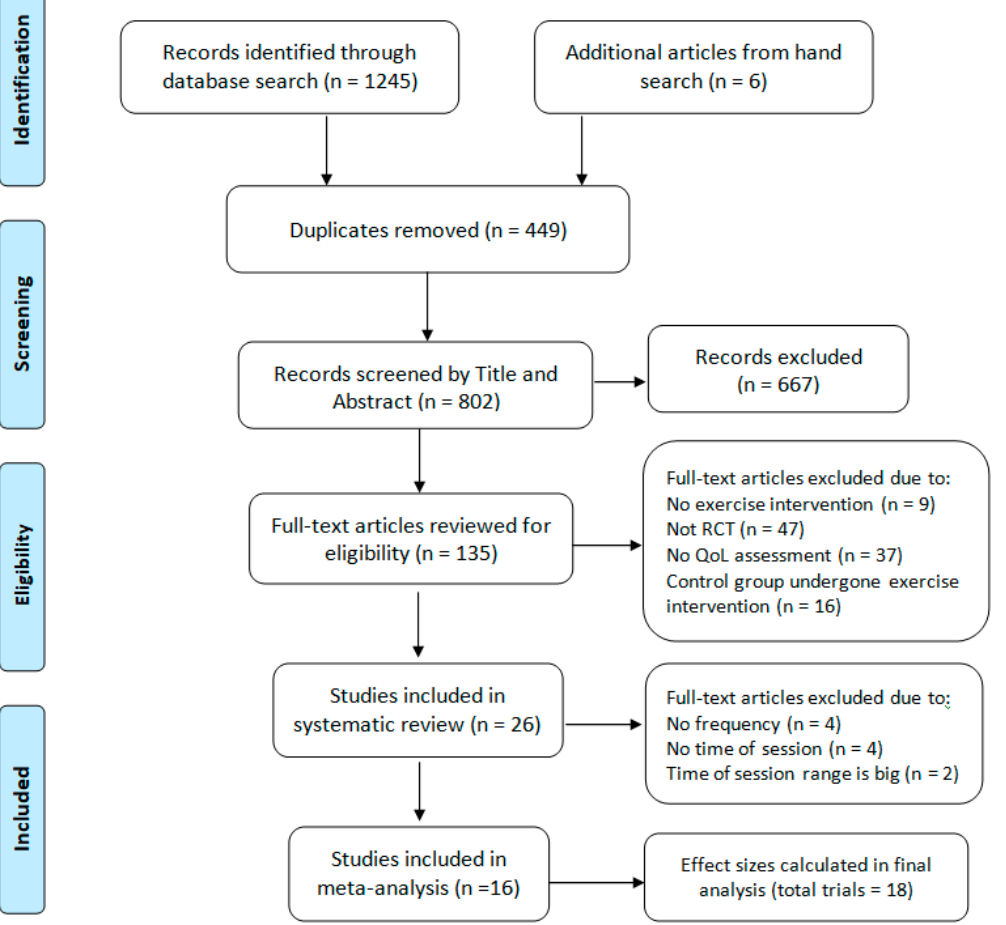
Figure 1. Flowchart of the study selection according to the Preferred Reporting Items for the Systematic Review and Meta-Analysis (PRISMA) method.